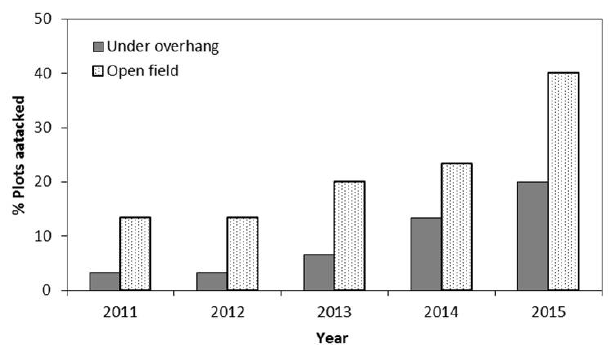
Fig 3 . Percentage proportion of concrete slab plots treated with cypermethrin attacked by termites over 5